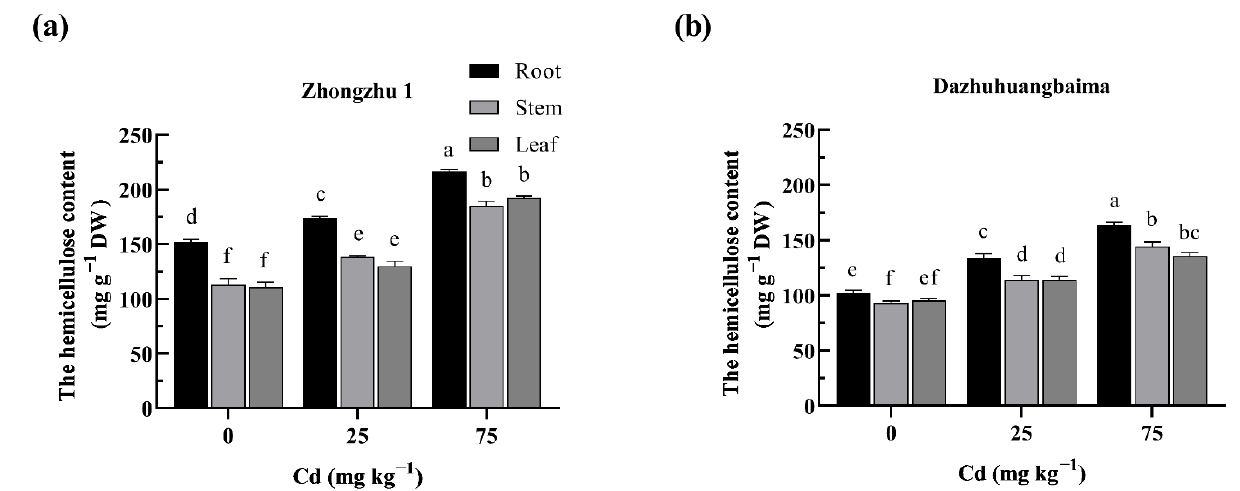
Figure 4. The hemicellulose contents in two ramie populations under Cd stress. The hemicellulose contents in: ( a ) ‘ Zhongzhu 1 ’ treated with 0, 25, and 75 mg kg −1 Cd; ( b ) ‘Dazhuhuangbaima’ treated with 0, 25, and 75 mg kg −1 Cd. DW, Dry weight. Data represent means ± SD ( n = 3). Different letters indicate significant differences at p ≤ 0.05.